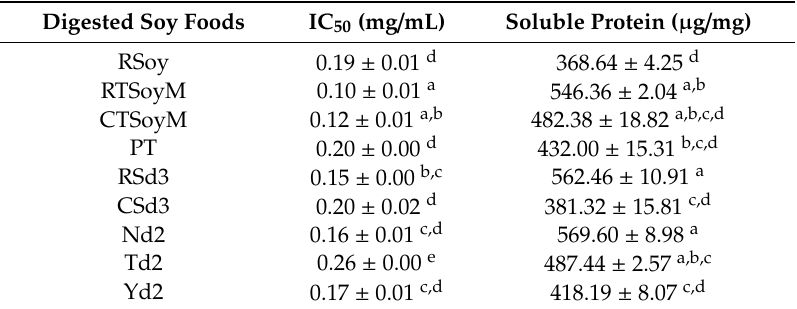
Table 1. Characteristics of the soy products after simulated in vitro